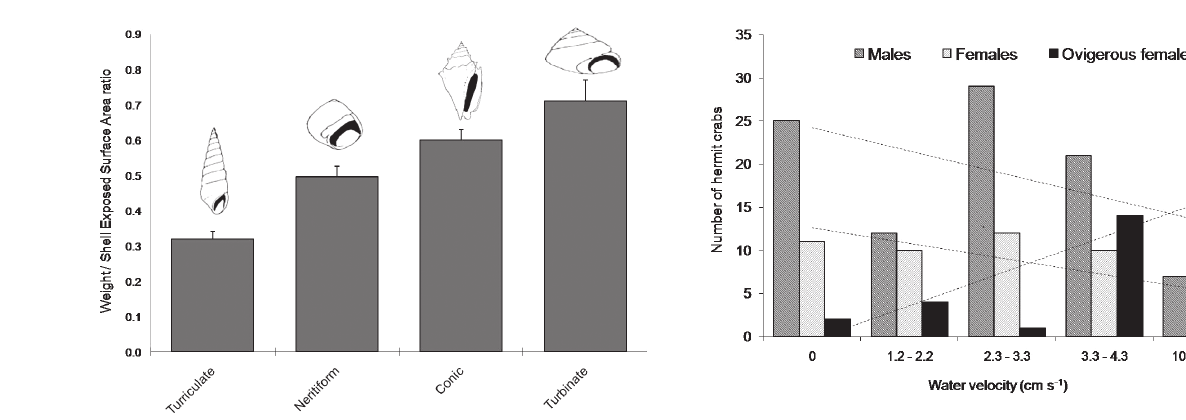
Fig . 1. – Weight / exposed surface Area ratio of the different types of shells occupied by the hermit crabs in montepio. mean values and standard errors are shown.